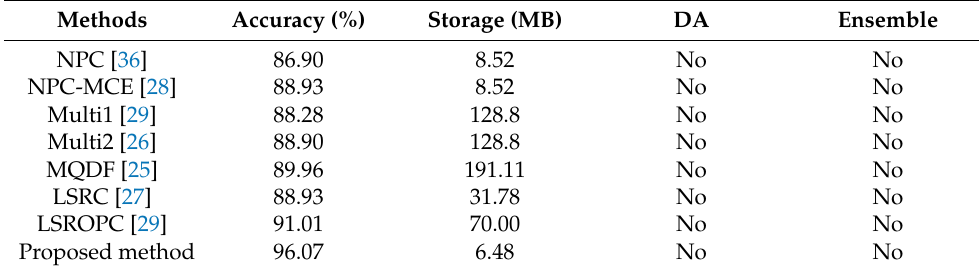
Table 5. Performance comparison of various methods on the IAHCC-UCAS2016 dataset.